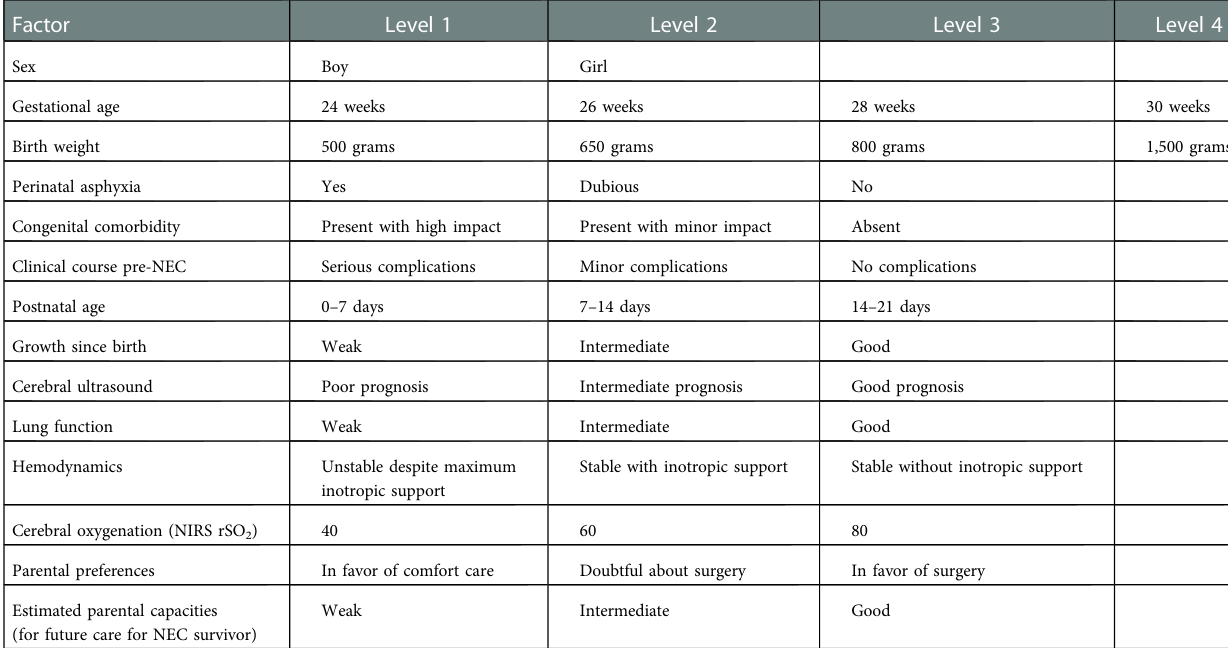
TABLE 1 Predetermined decision factors and their ranges within the prede fi ned